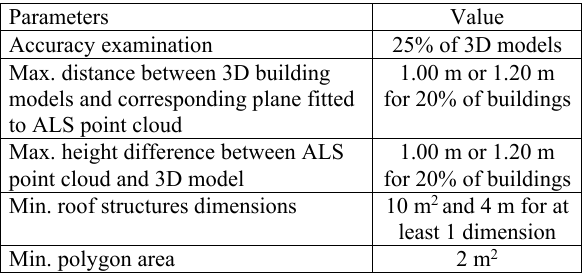
Table 1. Requirements for 3D building inspection.